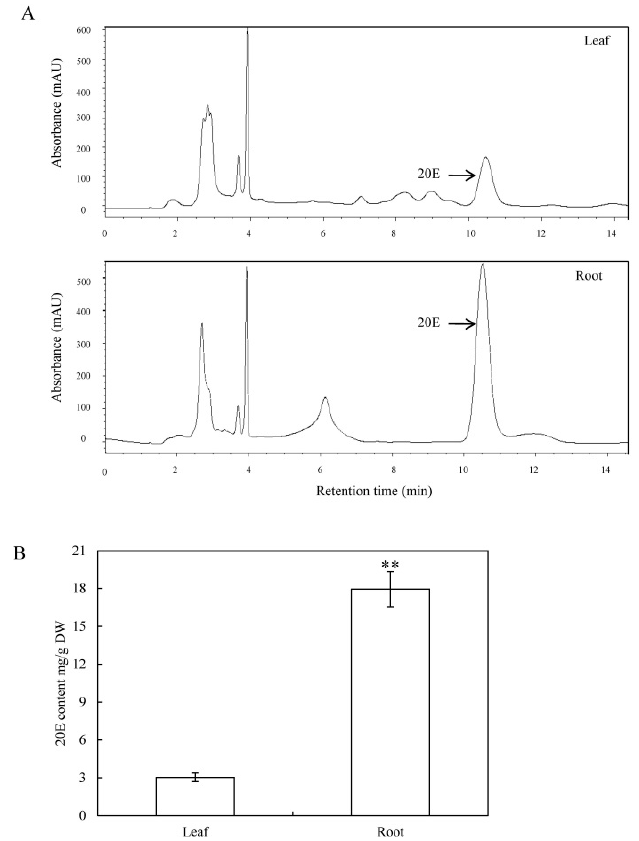
Figure 1. ( A ) Typical high-performance liquid chromatography (HPLC) chromatograms and ( B ) 20E contents in leaves and roots of C. arachnoidea . 20E was isolated from four-month old C. arachnoidea . Data are expressed as means ± standard deviation of three replicates. Statistical significance in comparison with the corresponding control values is indicated by ** p < 0.01.